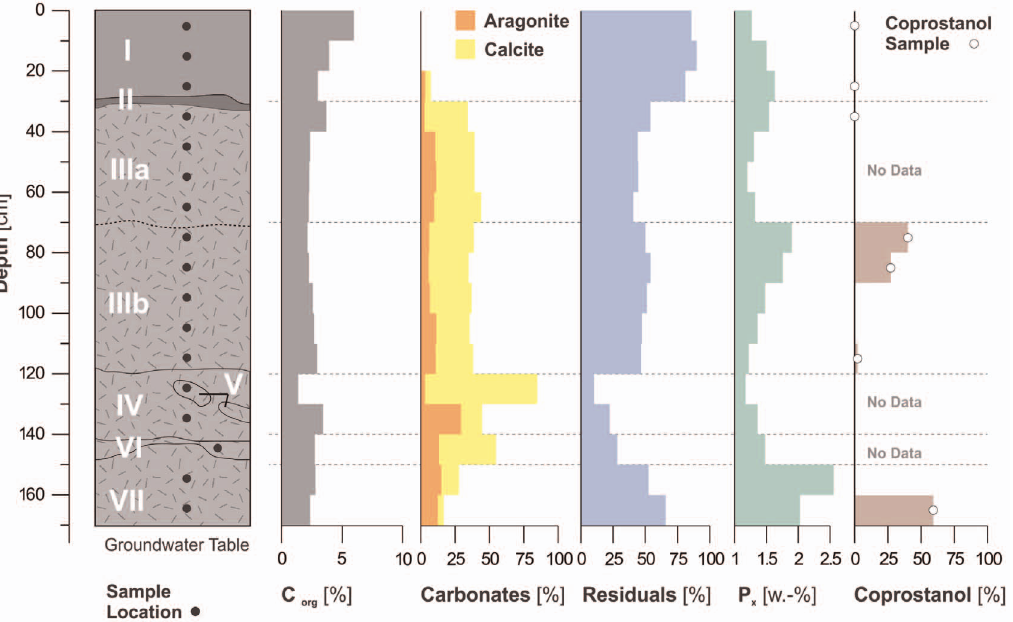
Figure 7. Stratigraphy, sampling sites and geochemical analyses of the profile at SM1. Residuals are mostly silt with small ( , 5%) amounts of clay and sand. Coprostanol is expressed as percentage of total detected steroids (see also Fig. 8).